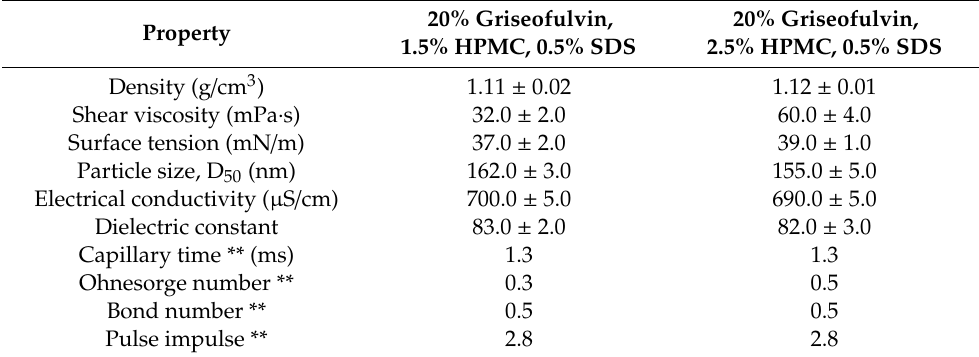
Table 1. Suspension properties at room temperature and characteristics of printing regime *.